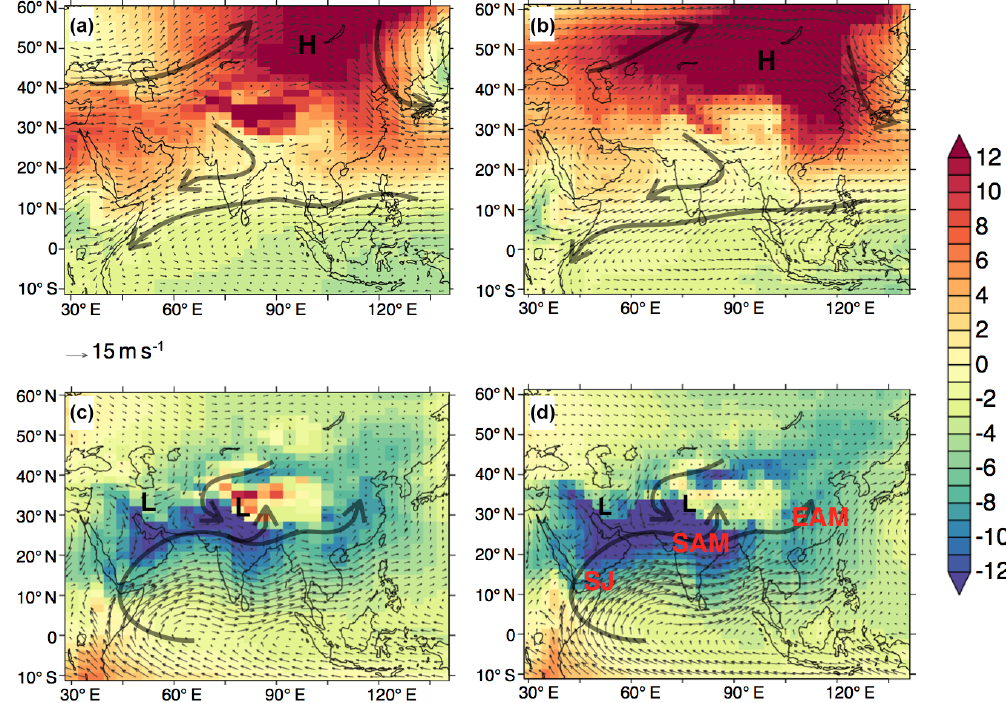
Figure 2. Comparison of (a, b) January to March and (c, d) June to August mean wind patterns obtained (a, c) in the modern control simulation (b, d) with ERA40 reanalysis. Shading represents sea level pressure anomaly (in millibars), calculated as the difference between seasonal SLP minus the mean annual SLP. Overprinted vectors show 850mbar wind speed expressed in metres per second. Main zones of high (low) pressure are highlighted with H (L) black letters. Main features of the summer monsoon are highlighted in red: Somali jet (SJ), South Asian monsoon (SAM) and East Asian monsoon